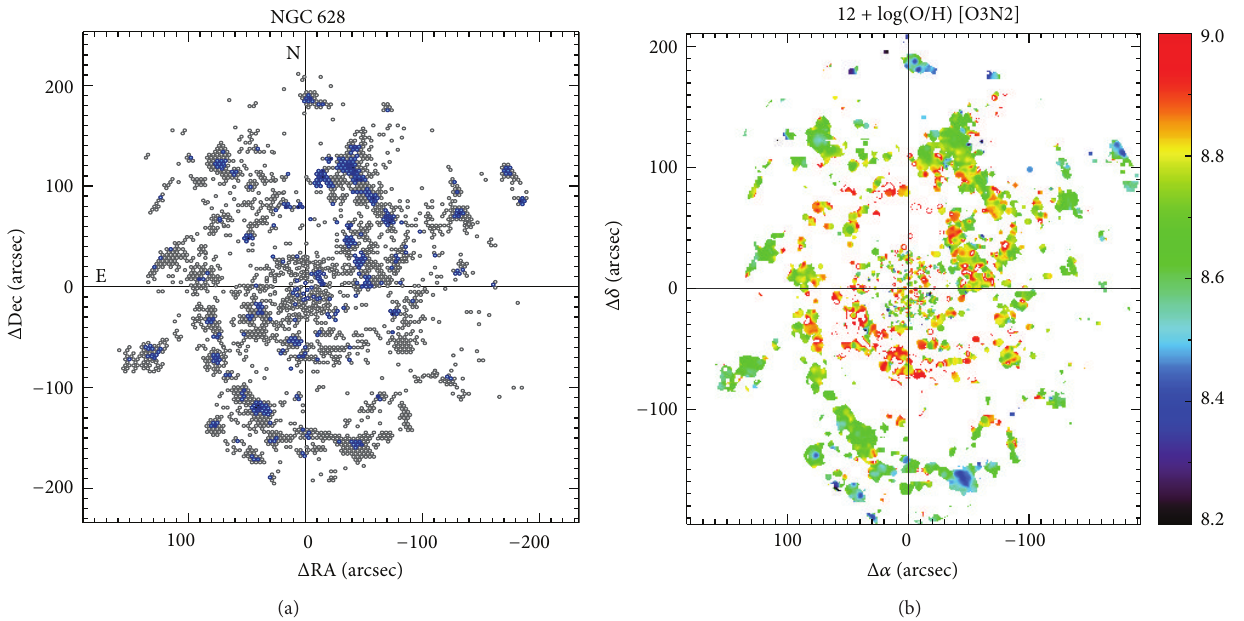
Figure 2: (a) Spatial map of the fibres within the IFS mosaic of NGC 628 where nebular emission was detected. Blue fibres indicate regions above a S/N threshold for a proper abundance analysis, and grey fibres correspond to a diffuse emission. The size and position of the fibres (at real scale) are displayed in the standard NE-positive orientation. The crosshairs mark the central reference point of the IFS mosaic. The colour intensity of each fibre in the blue sample has been scaled to the flux intensity of H 𝛼 for that particular spectrum. (b) Oxygen abundance map of NGC 628 derived by applying the O3N2 calibrator [28] to the emission line maps of the galaxy. The figure shows a clear gradient in metallicity, with more abundant regions in the inner part or the galaxy. Figure adapted from S´anchez et al. [29] and Rosales-Ortega et al.